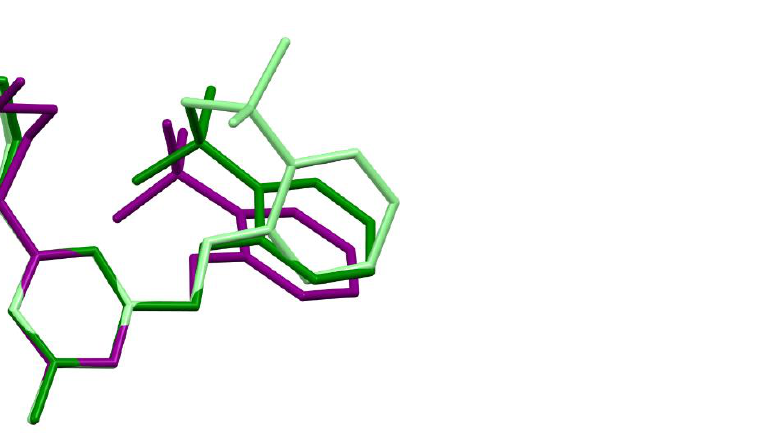
Figure 5. The overlap of the triazine rings of molecule A (light green) and molecule B (green) of compound 3 and the cation of salt 3-SA (purple). H atoms have been omitted for clarity.